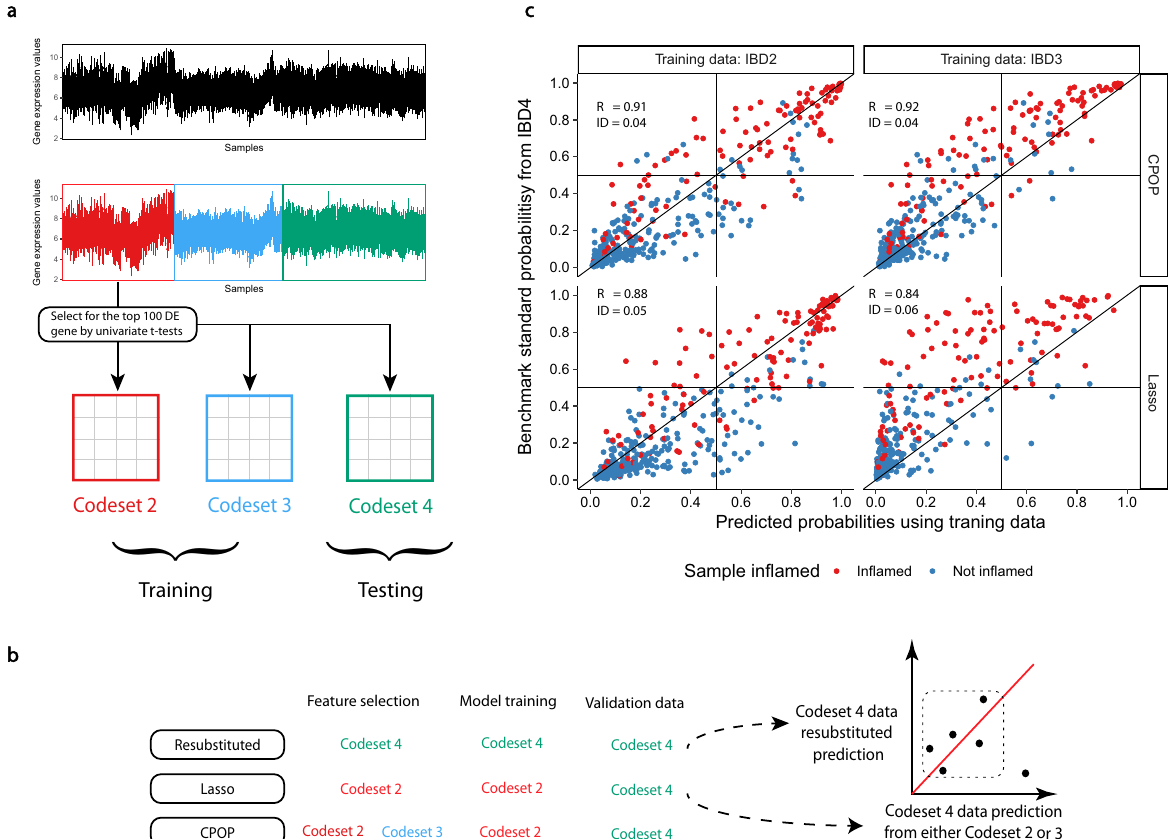
Fig. 4 Validation results of the IBD dataset. a Schematic drawing of the pre-processing steps of the IBD data. Due to reagent set changes, samples in this data are separated into three major batches. Top 100 DE genes are selected from the IBD2 cohort to reduce the number of features used for modelling. b Schematic drawing of the evaluation steps of the IBD data. Treating both the CPOP and Lasso methods as feature selection methods only and using the ridge regression model, we compare the predicted values against benchmark standard values where the feature selection, model training and validation data are identical. c Scatter plots comparing predicted probabilities of in fl ammation. The CPOP method is able to produce prediction values that are more consistent between different batches (codesets) with higher correlation (denoted as R in the fi gure) and closer to the benchmark standard prediction values (denoted as ID in the fi